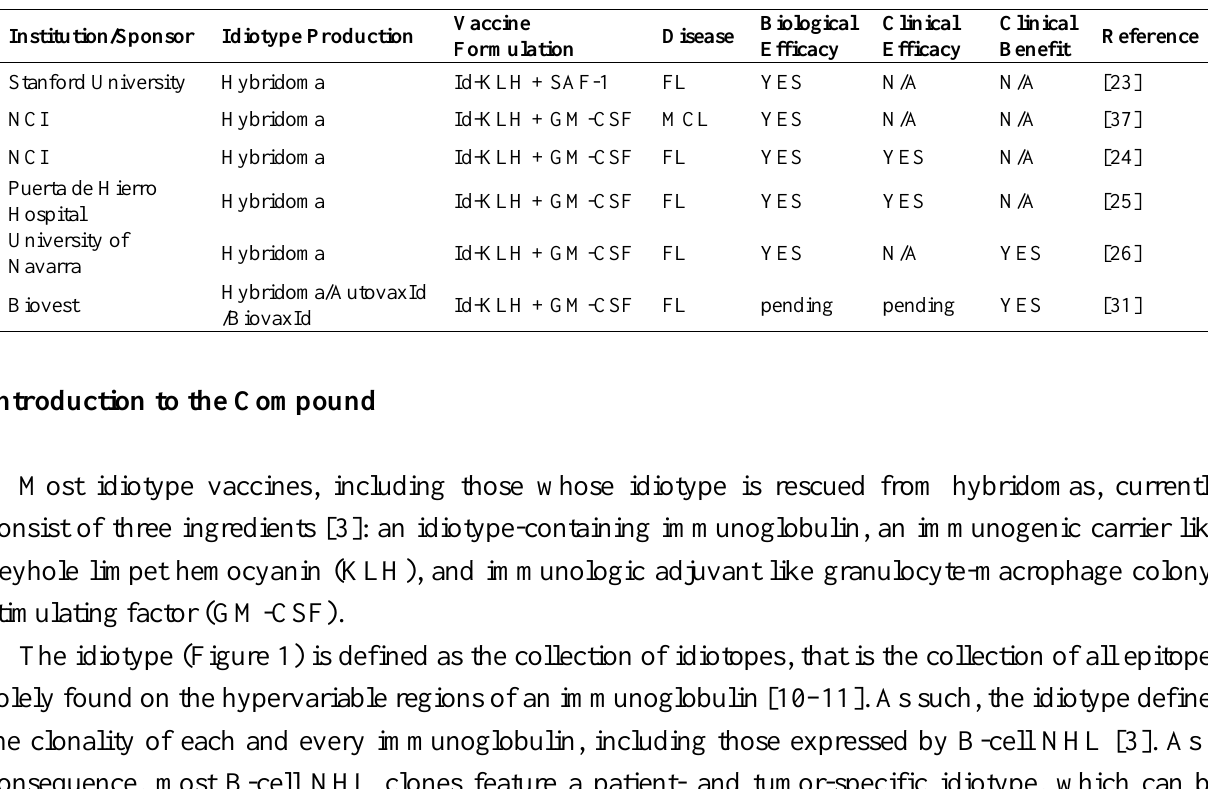
Table 1. Major studies on hybridoma-derived idiotype vaccine for lymphoma. Legend: Id: idiotype; KLH: keyhole limpet hemocyanin; FL: follicular lymphoma; MCL: mantle cell